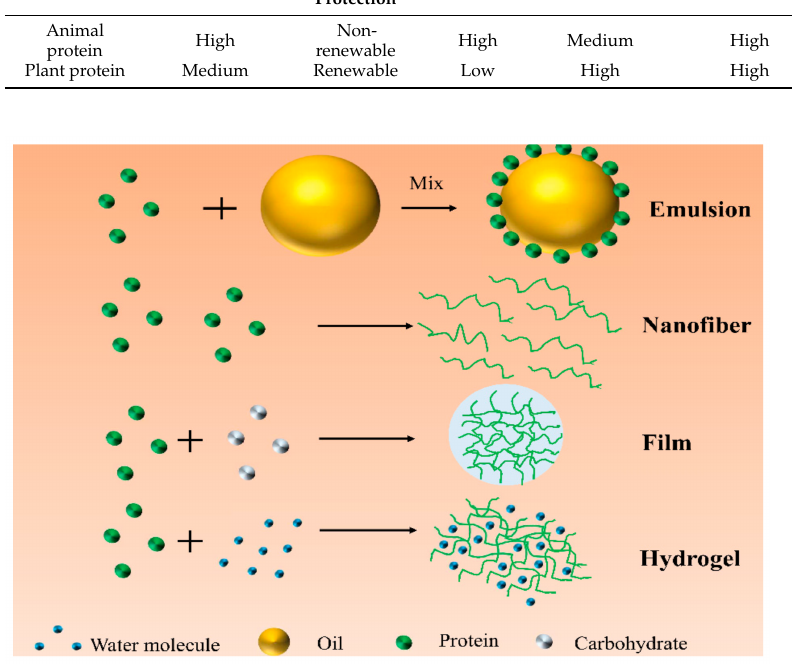
Figure 1. Schematic diagram of different types of protein-based